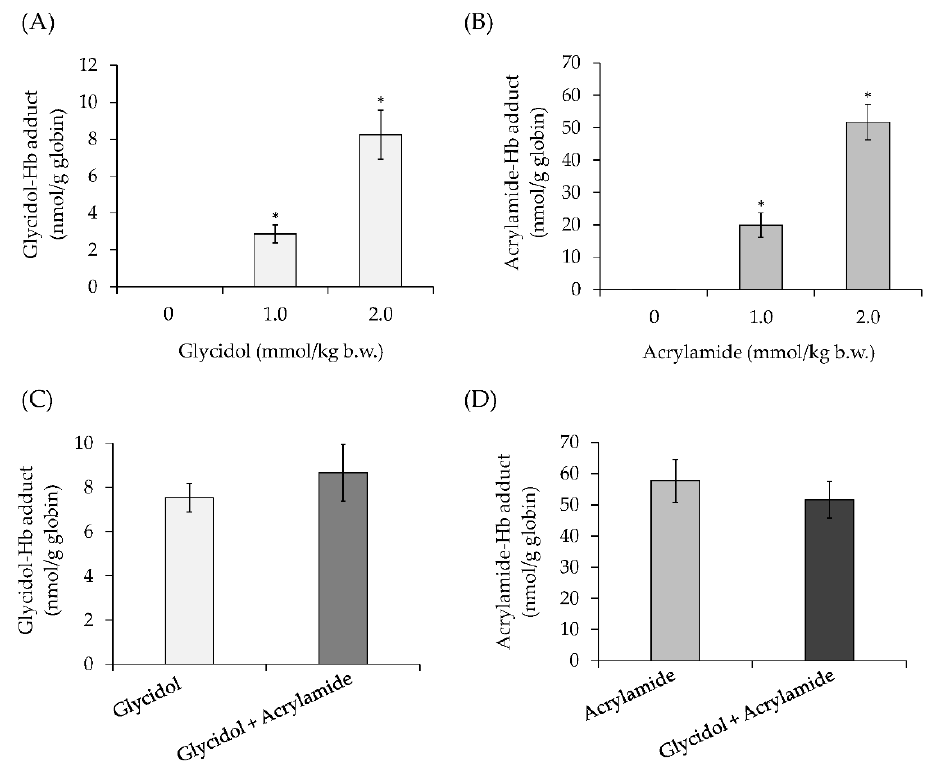
Figure 5. Hemoglobin (Hb) adduct formation in vivo in mice exposed to a combination of glycidol and acrylamide (in vivo). ( A ) Glycidol – Hb adduct formation following administration of glycidol alone to mice. ( B ) Acrylamide – Hb adduct formation following administration of acrylamide alone to mice. ( C ) Glycidol – Hb adduct formation in mice exposed to a combination of glycidol and acryla- mide. ( D ) Acrylamide – Hb adduct formation in mice exposed to a combination of glycidol and acrylamide. * The significance level was p < 0.05 compared with the glycidol alone at each concen- tration. The values represent the mean standard deviation (SD) of four independent experiments.